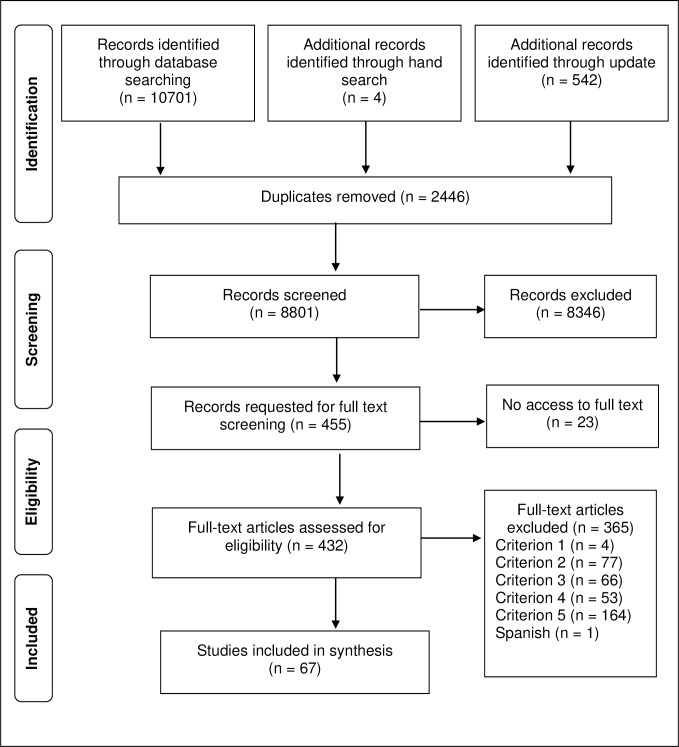
PRISMA flowchart.